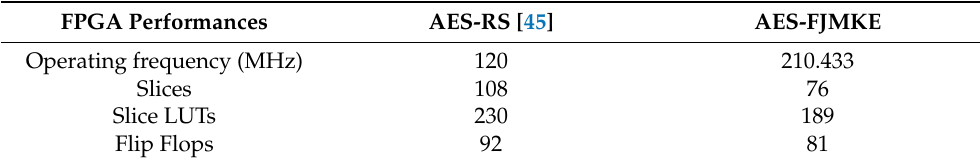
Table 12. Comparison of AES-FJMKE and AES-RS for Spartan 6.